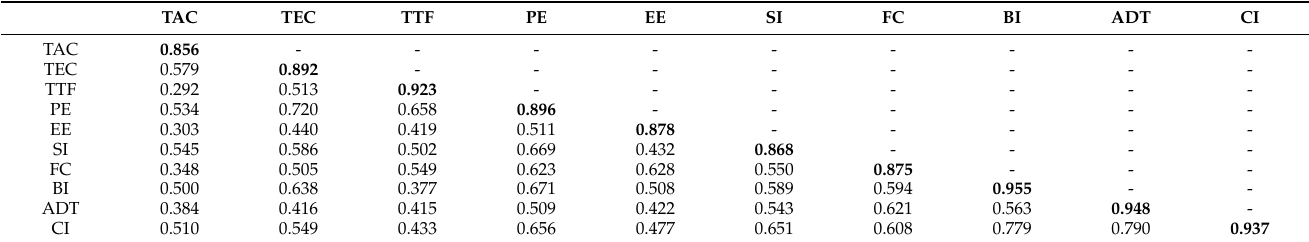
Table A1. The square root of AVEs (in bold) and correlation